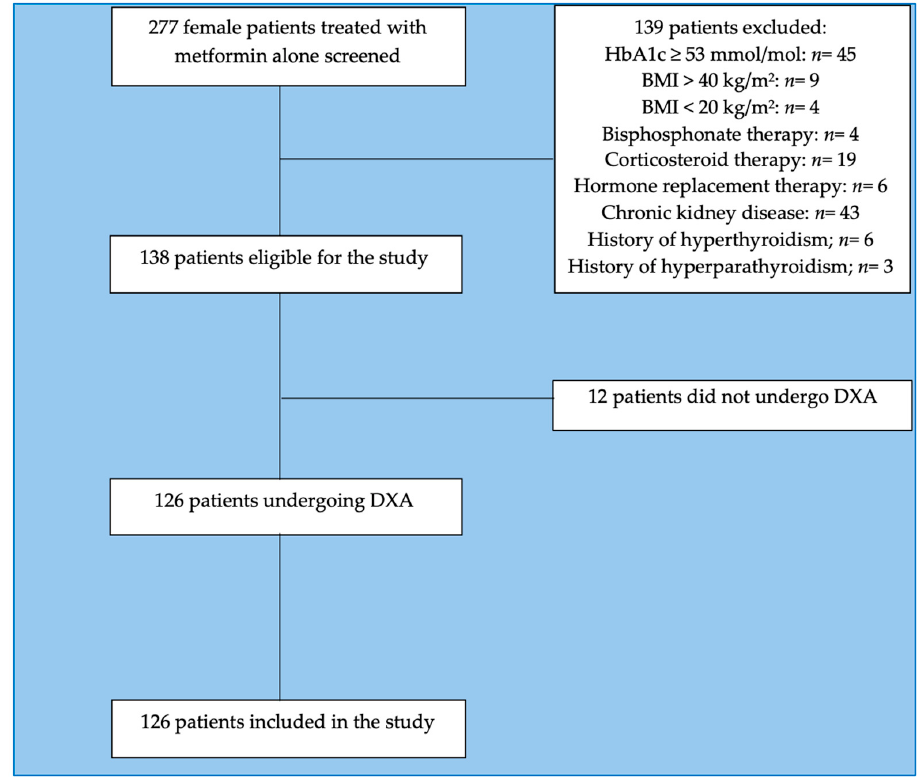
Figure 1. CONSORT flow-chart of the study. Abbreviations: BMI: body mass index, HbA1c: glycosylated hemoglobin. Table 1. Differences in clinical and biochemical features between T2DM patients and controls.